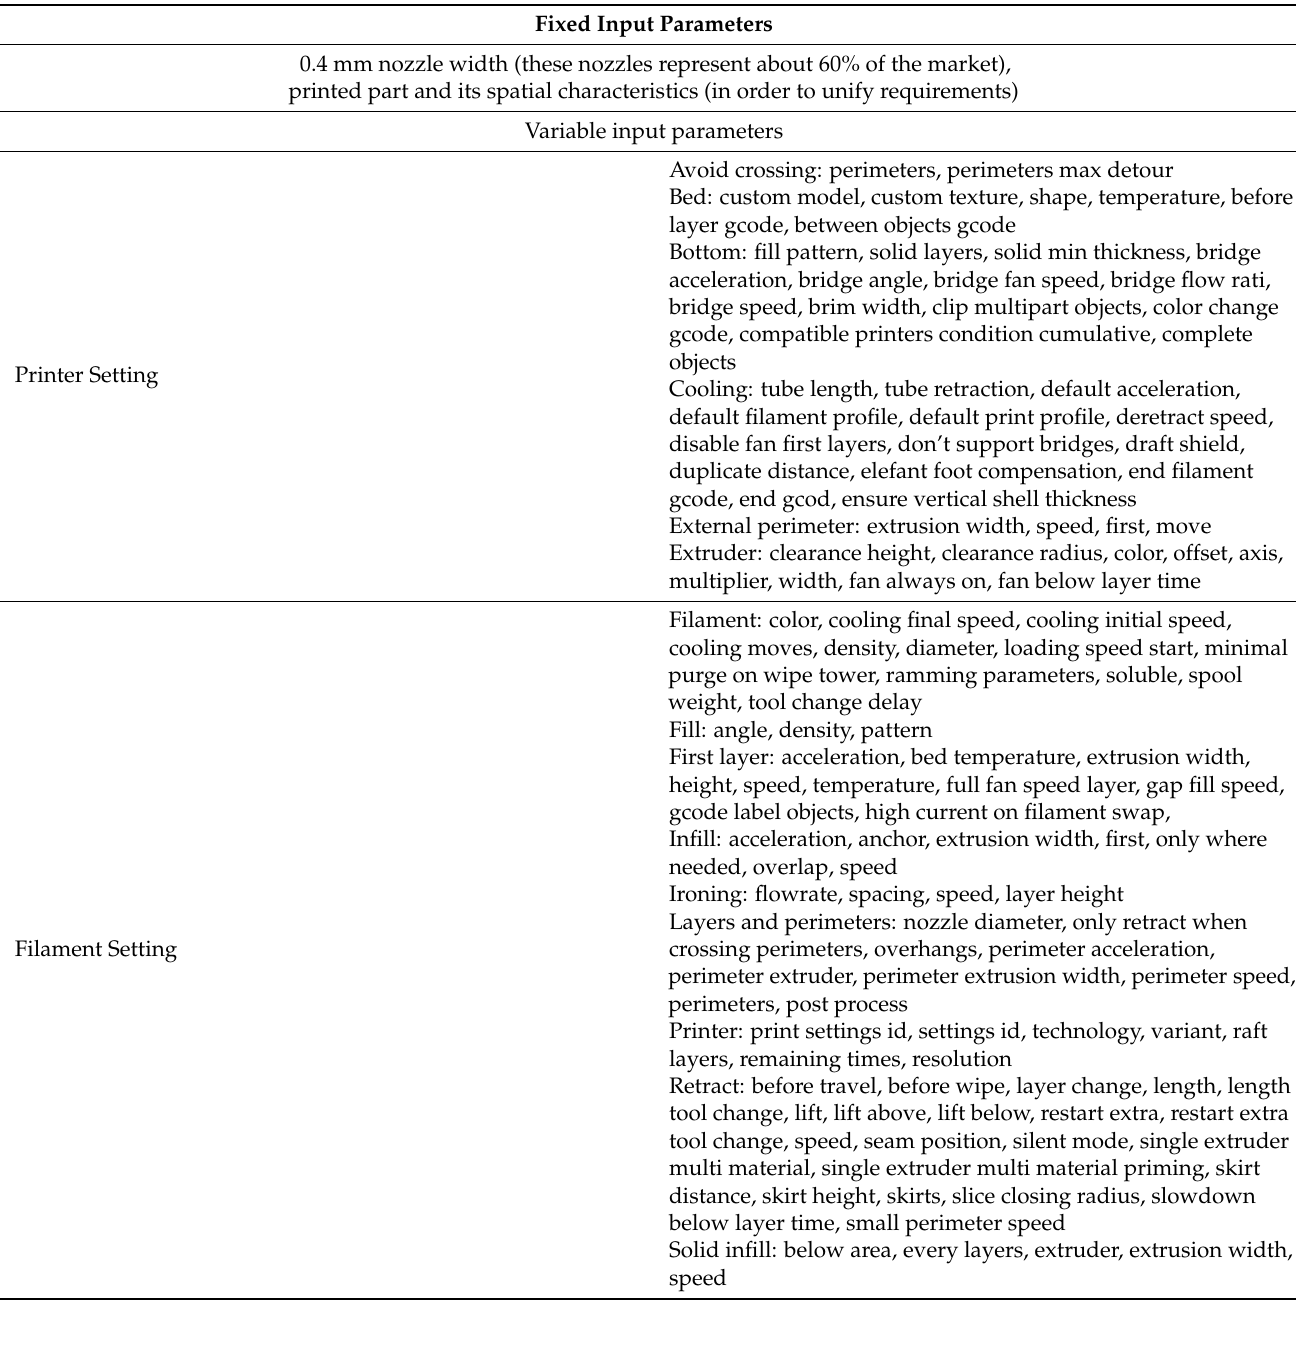
Table 2. Decreased number of 142 input parameters of the neural